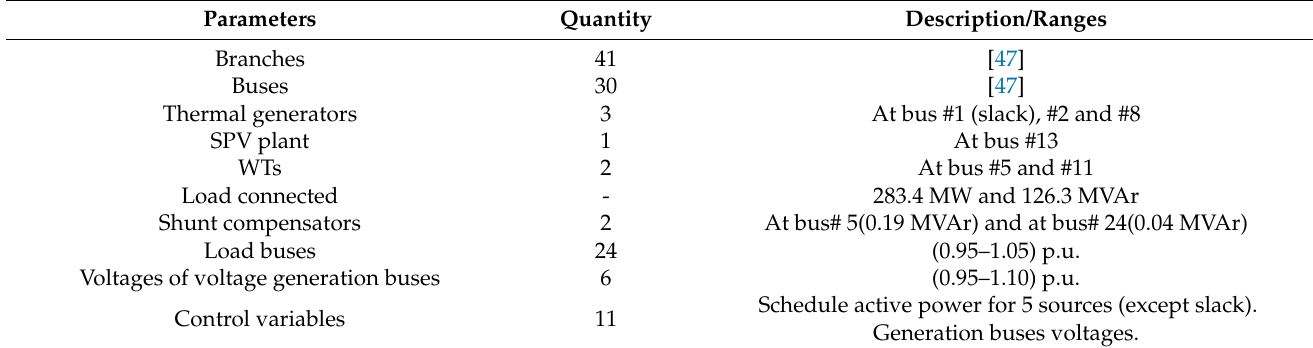
Table 1. Adopted test system details.